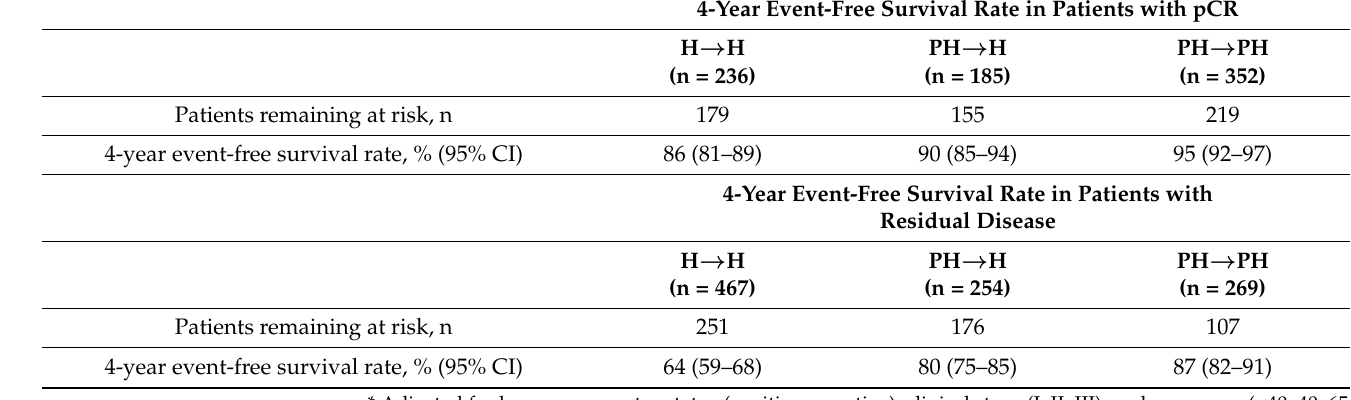
Table 4. Four-year event-free survival rate in patients with and without a pathological complete response by treatment modality using inverse probability of treatment weighting analysis